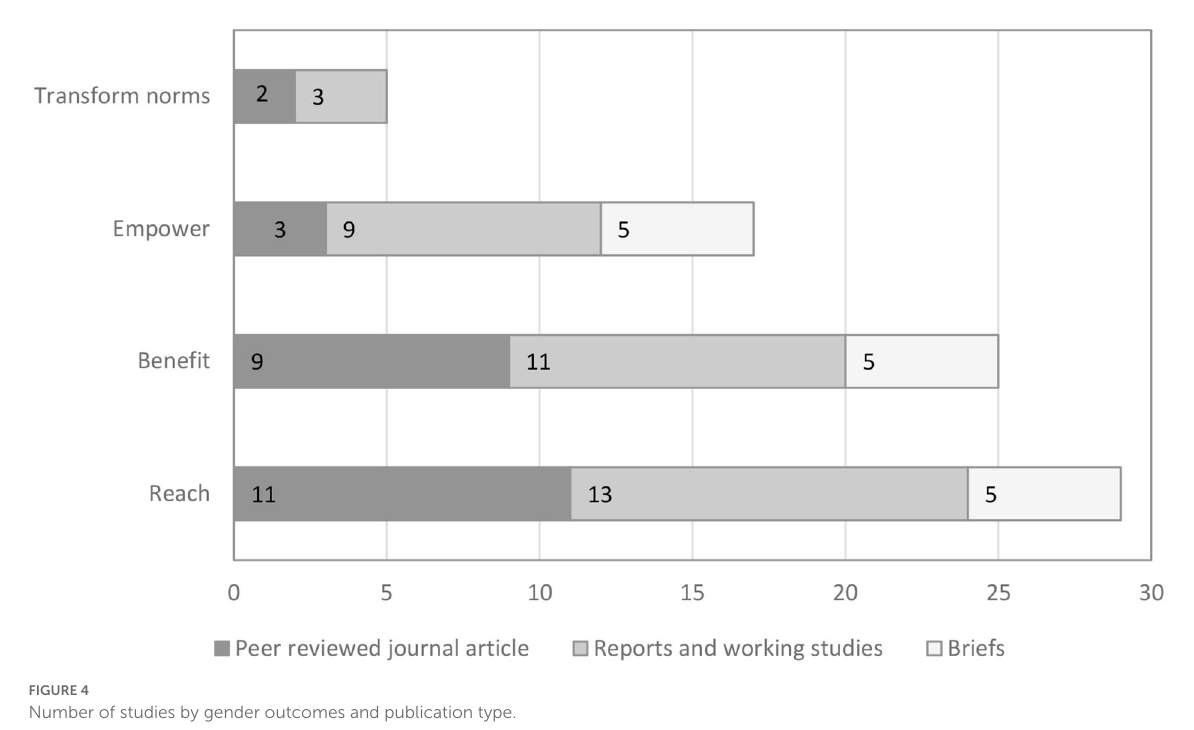
FIGURE4 Number of studies by gender outcomes and publication type.